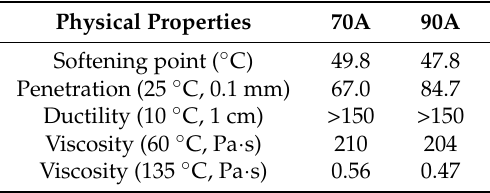
Table 1. Physical properties of 70A and